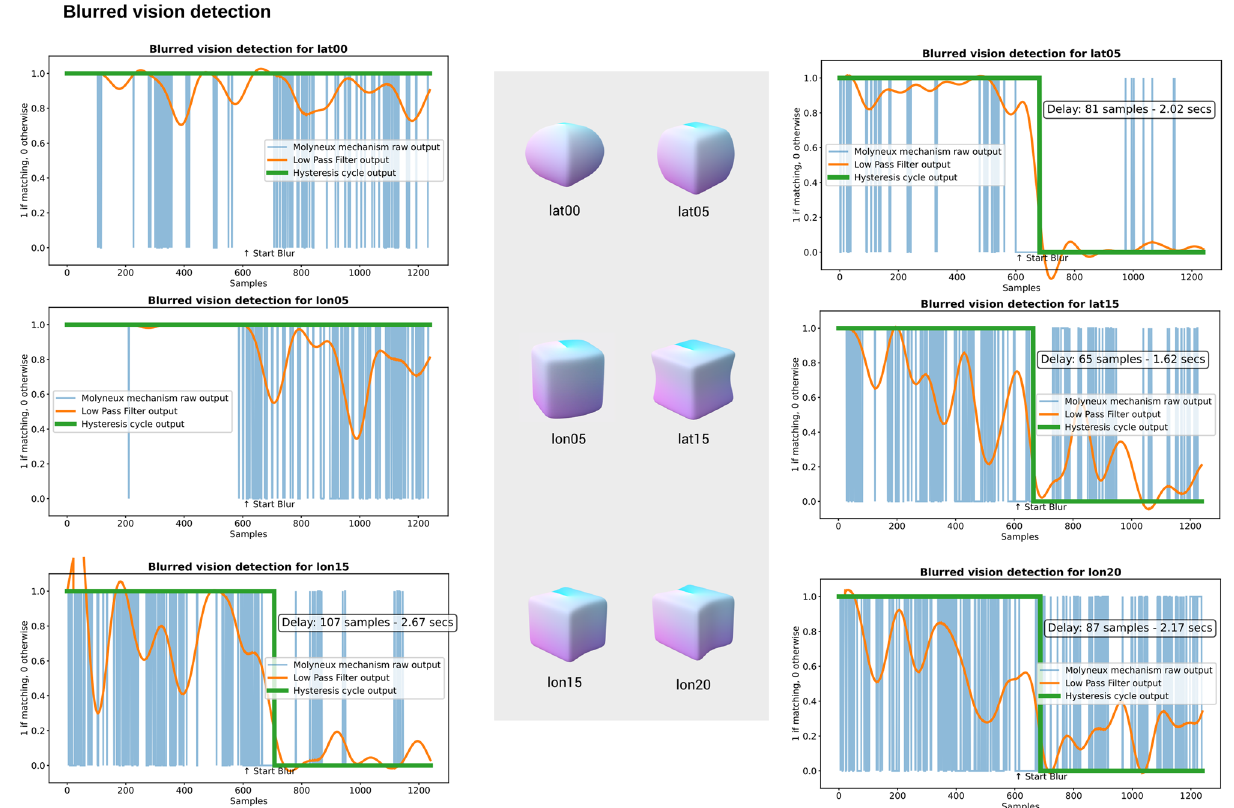
Figure 5. Blurred vision detection through Molyneux mechanism and filtering. By applying the Molyneux mechanism to every visual-haptic pair, the ACS can determine if the two channels are matching or not, hence it can detect failures in one channel. Although there is a clear trend towards the two channels matching when both are working properly, short mismatches can appear (blue plot). In order to obtain an accurate decision whether the channels are matching or not, a low pass filter is applied to attenuate these mismatches (orange plot). Finally, as a way to offer a binary response that decides if the vision is blurred or not, the filter output goes through a hysteresis cycle (green plot). With this entire process the detection of the blurred vision is not immediate and has an average delay of 2.13 s (85.33 samples). Note that there is no mismatch in lat00 and lon05, that is, for these two objects the blur filter does not affect the recognition